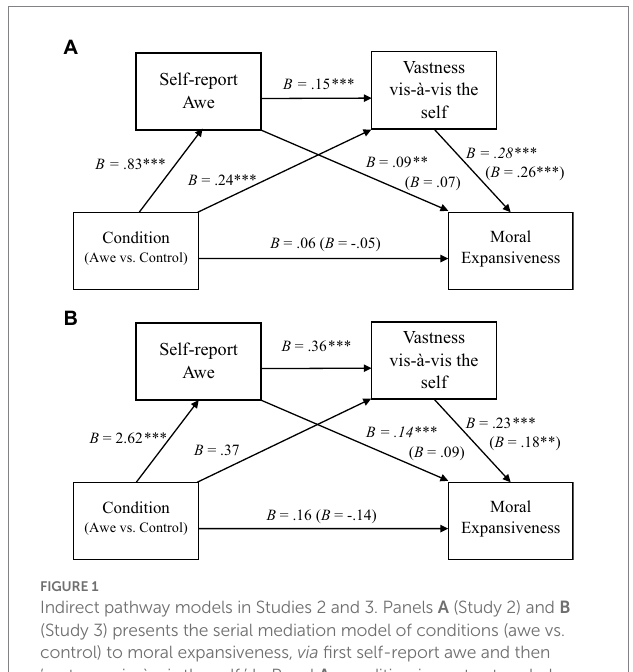
FIGURE 1 Indirect pathway models in Studies 2 and 3. Panels A (Study 2) and B (Study 3) presents the serial mediation model of conditions (awe vs. control) to moral expansiveness, via first self-report awe and then ‘vastness vis-à-vis the self.’ In Panel A , condition is contrast coded (negative awe = 1, non-nature awe = 1, control = − 2). In Panel B , condition is a binary (control = 0, awe = 1). Unstandardized coefficients are presented. Numbers in parentheses indicate coefficients when all variables are predicting moral expansiveness. * p < .05, ** p < .01, *** p <